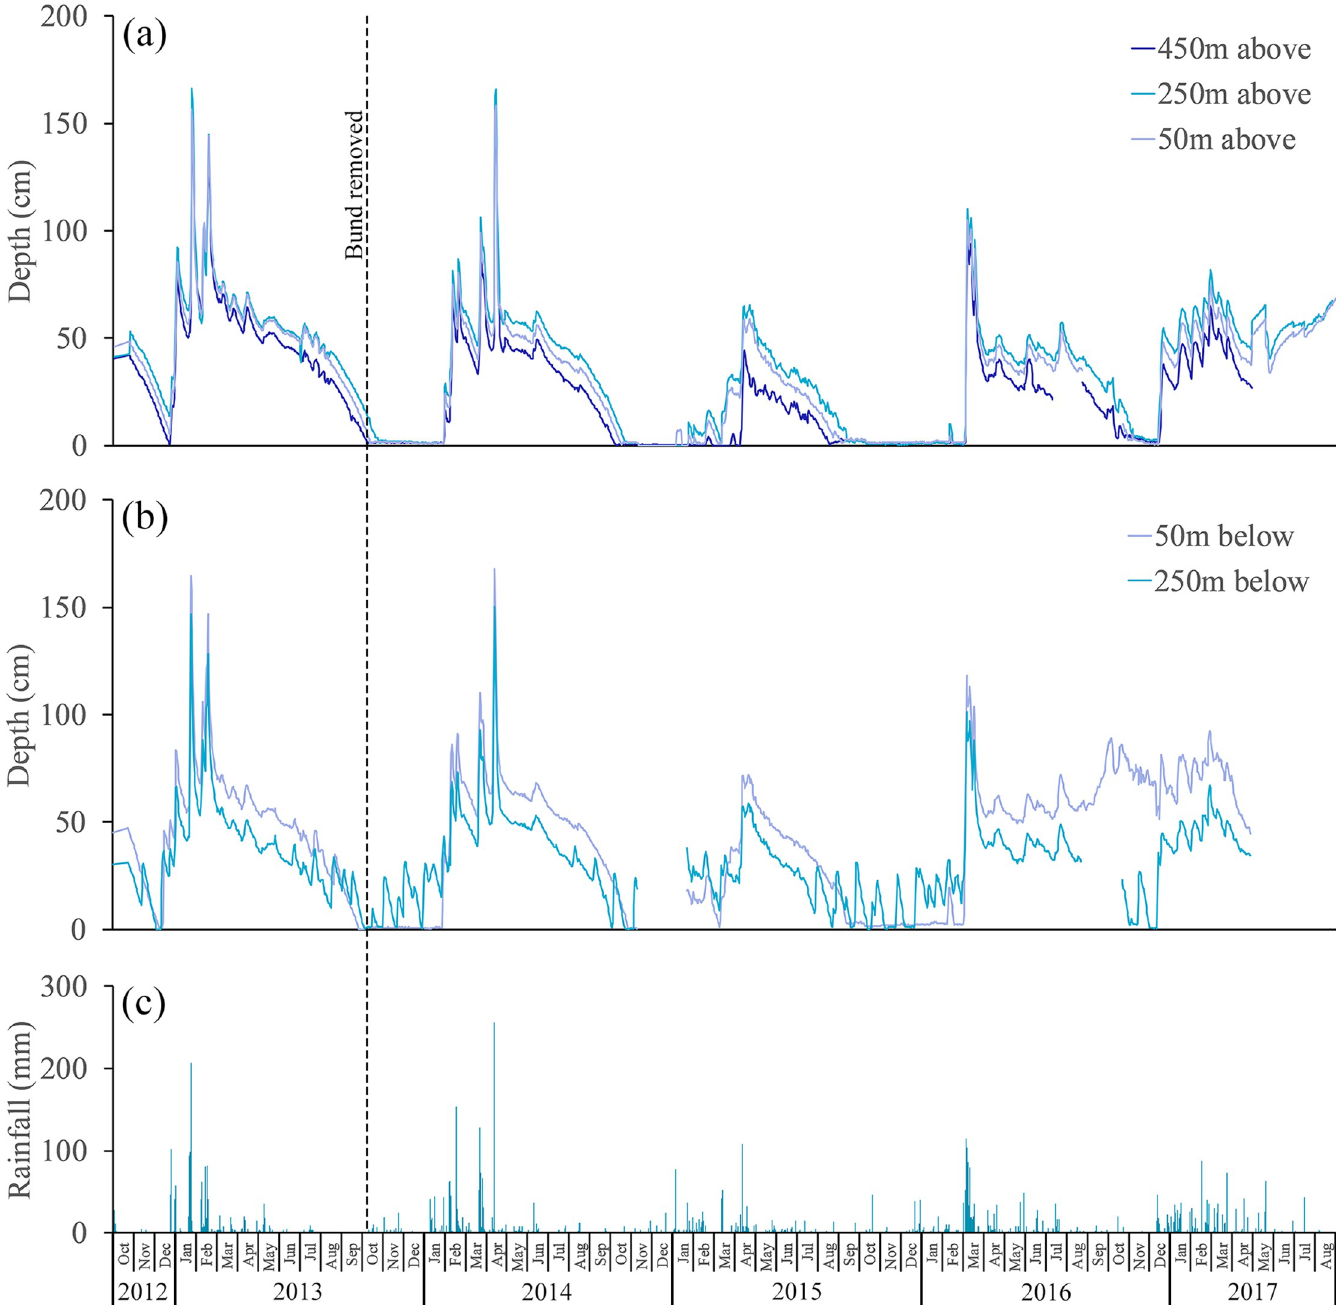
Fig 2. Changes in depth above and below the bund location and daily rainfall—October 2012 to August 2017. Logger distances above the bund (a) are 450 m, 250 m and 50 m and below (b) are 50 m and 250 m. The bund was removed on the 6 th October 2013. Daily rainfall (c) was derived from the nearby Bureau of Meteorology station at Allingham approximately 2.5 km